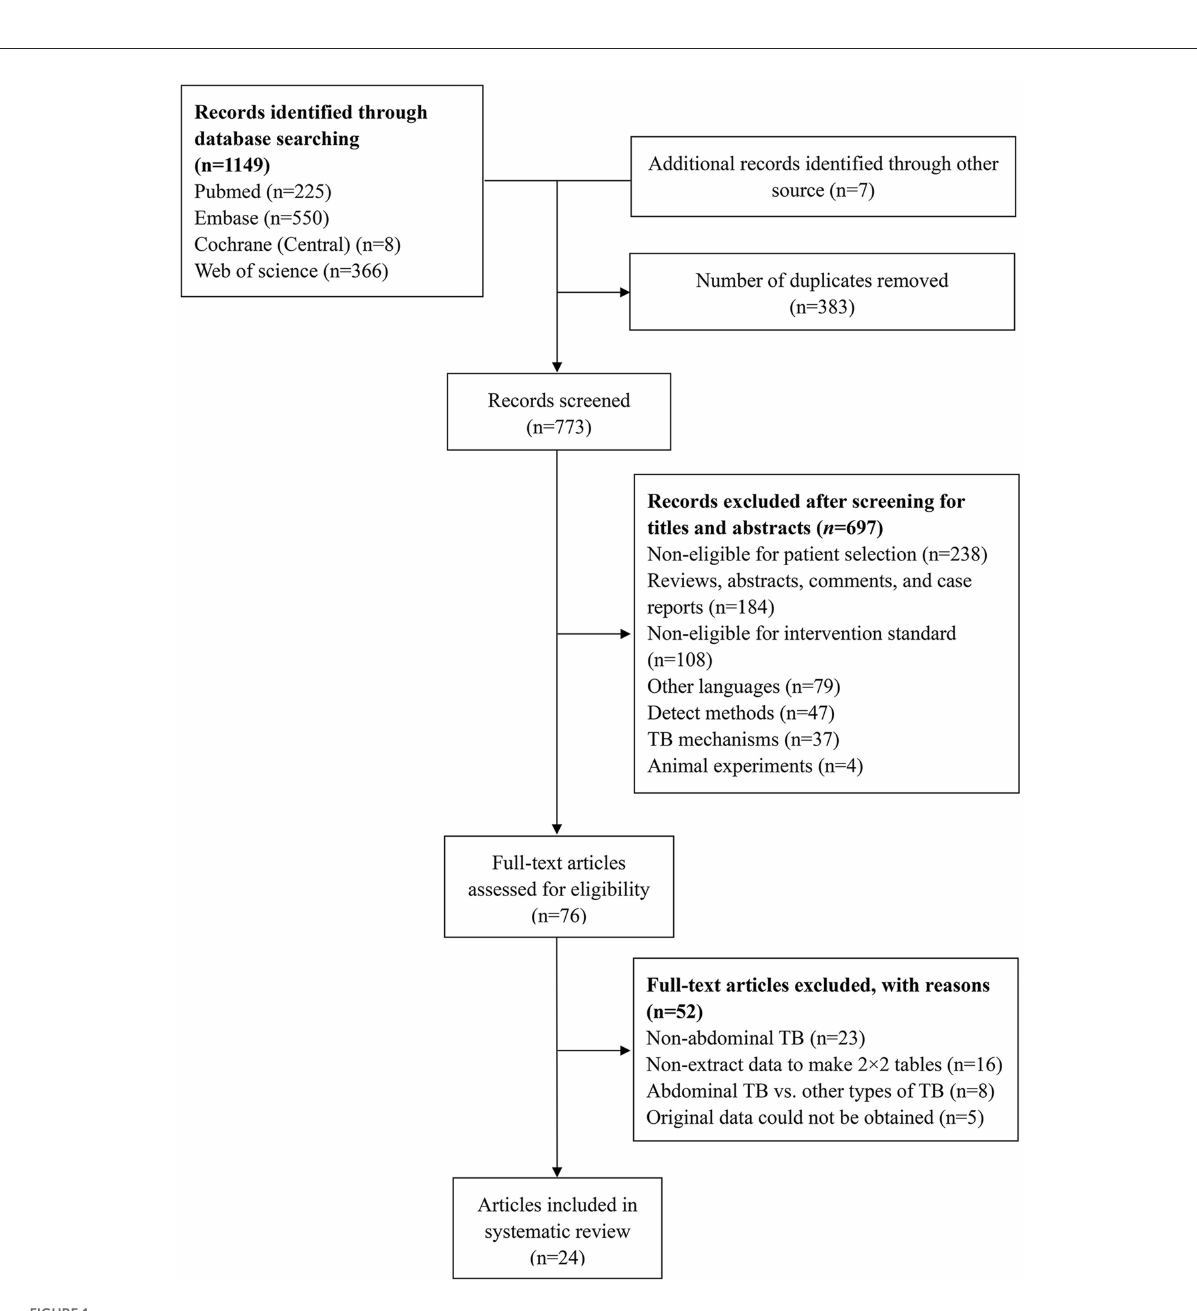
FIGURE1 Flow chart of the process of the identified articles regarding ADA and abdominal